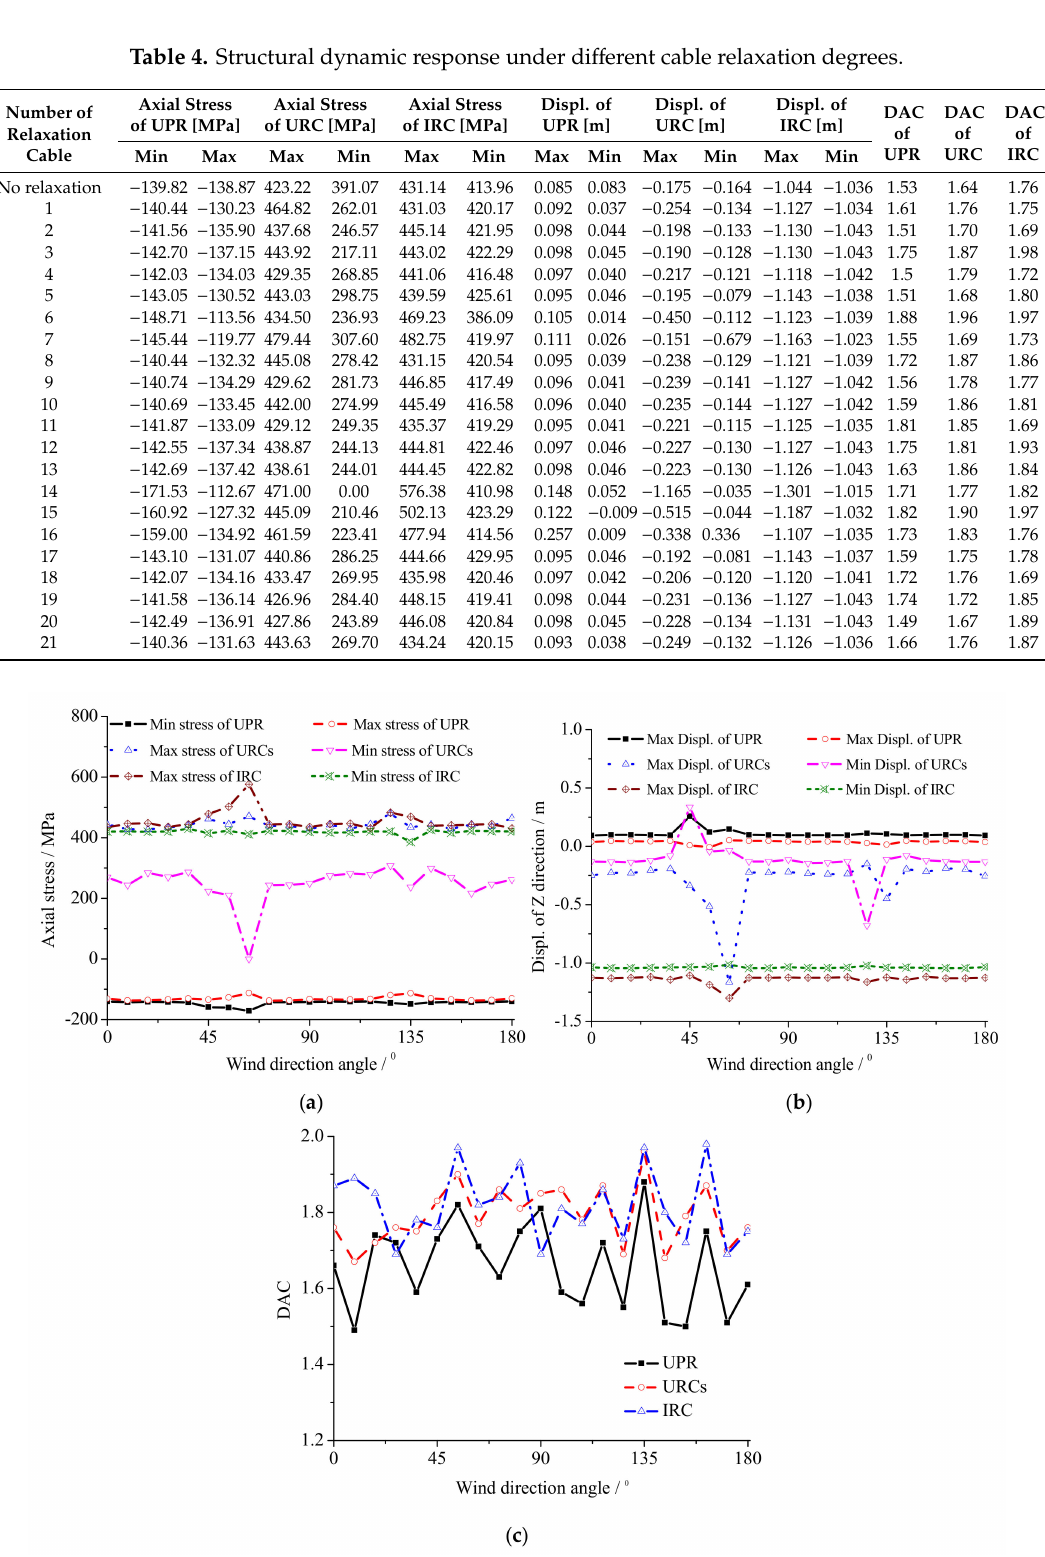
Figure 10. Greatest response distributions of the structure for di ff erent wind direction angles. ( a ) Axial stress VS. wind direction angle; ( b ) Displ. of Z direction VS. wind direction angle; ( c ) DAC VS. wind direction